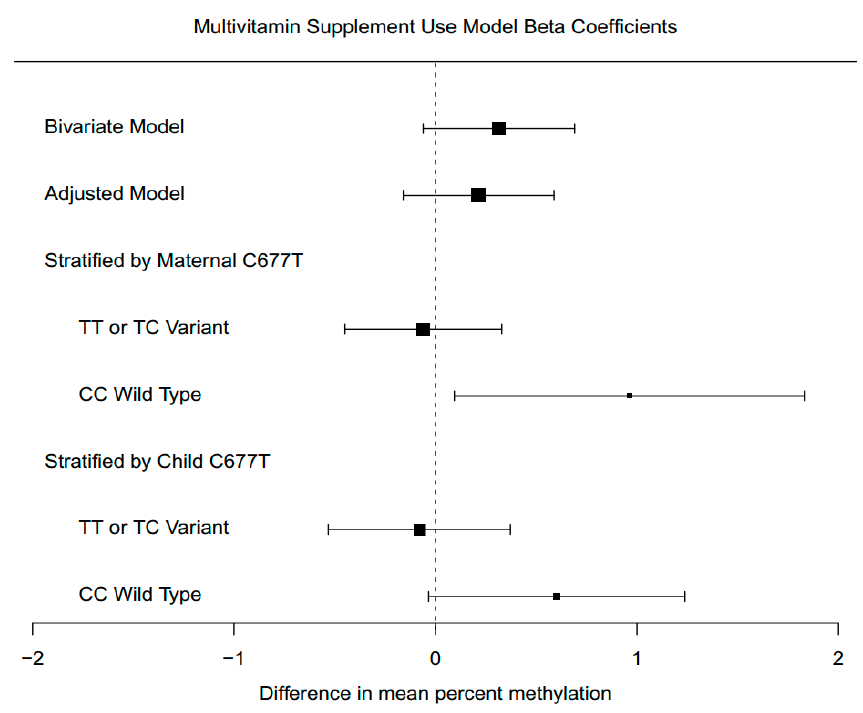
Figure 2. Estimated model coefficients for effect of prepregnancy multivitamin use. Models were adjusted for sex, maternal age, maternal education, ancestry, batch, and cell type proportions for nucleated red blood cells and granulocytes.